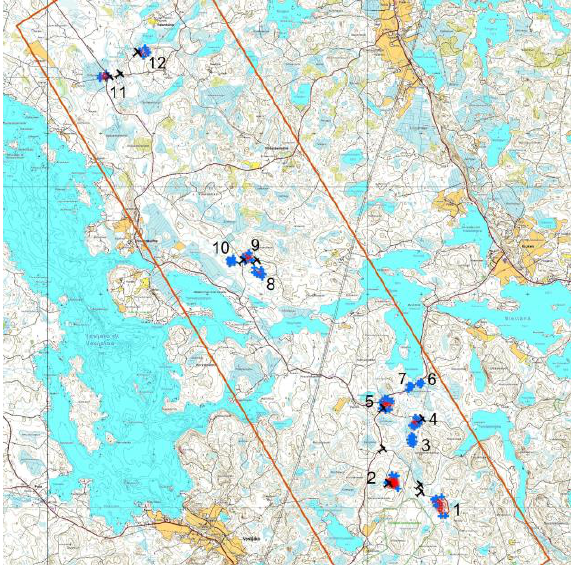
Figure 2. Vesijako test site. Numbers indicate 12 reference sites (red line indicates the airspace reservation area).